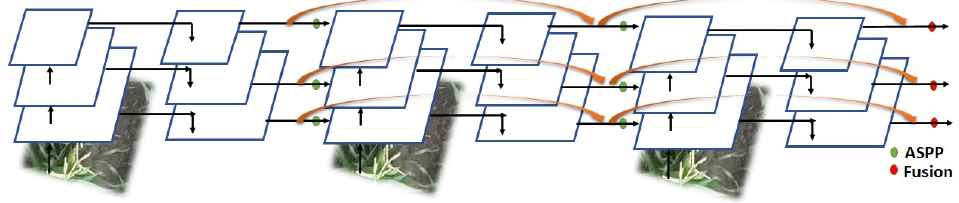
Figure 6. Tassel